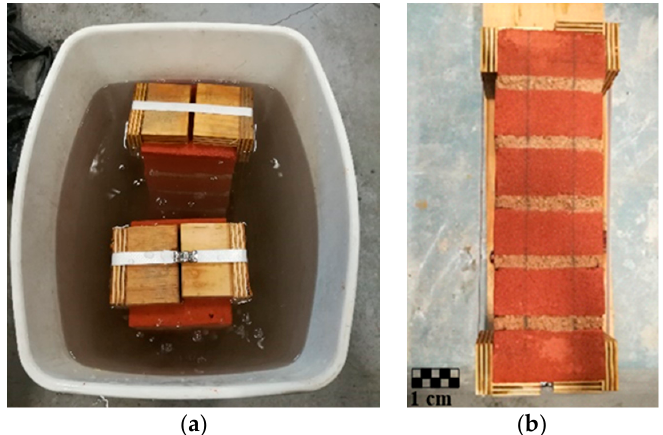
Figure 2. Preparation of specimen before the application of the steel-reinforced grout (SRG) composite: ( a ) masonry blocks soak in the water, ( b ) wet specimen removed from the bucket.